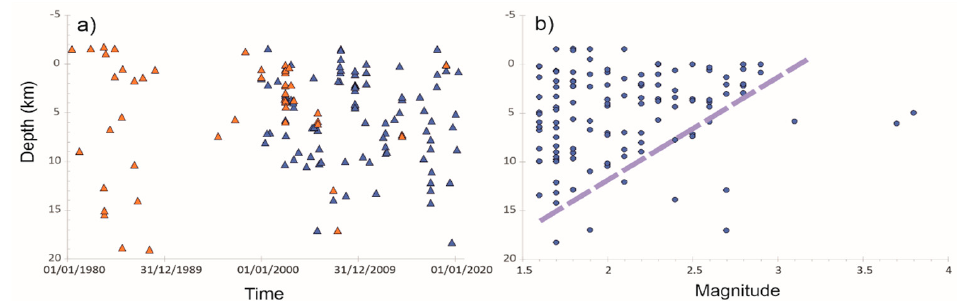
Figure 8. ( a ) Diagram showing time vs. depth for C2.5 catalogue (red triangles) and for CALL catalogue (blue triangles); ( b ) diagram showing magnitude vs. depth (see text for details).